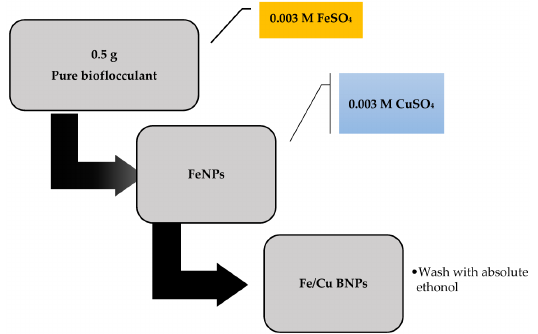
Figure 1. Schematic of the Fe/Cu BNPs synthesis process.